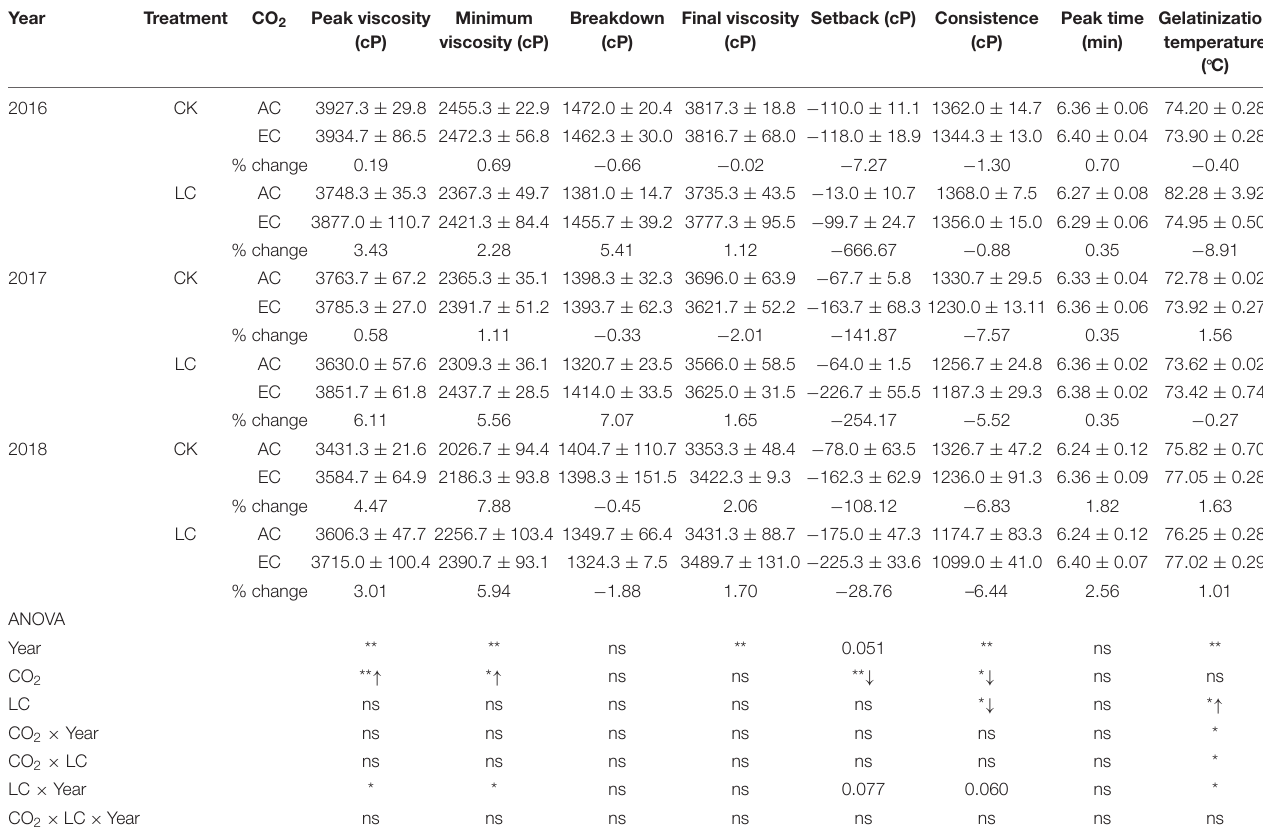
AC and EC refer to ambient CO 2 and elevated CO 2 , respectively. Arrows in the treatment column indicate treatment increased ( ↑ ) or decreased ( ↓ ) the values. Values are means ± standard error (n = 3). Statistically significant effects are indicated as **P < 0.01; *P < 0.05. The value indicates the probability between 0.05 and 0.1. ns, not